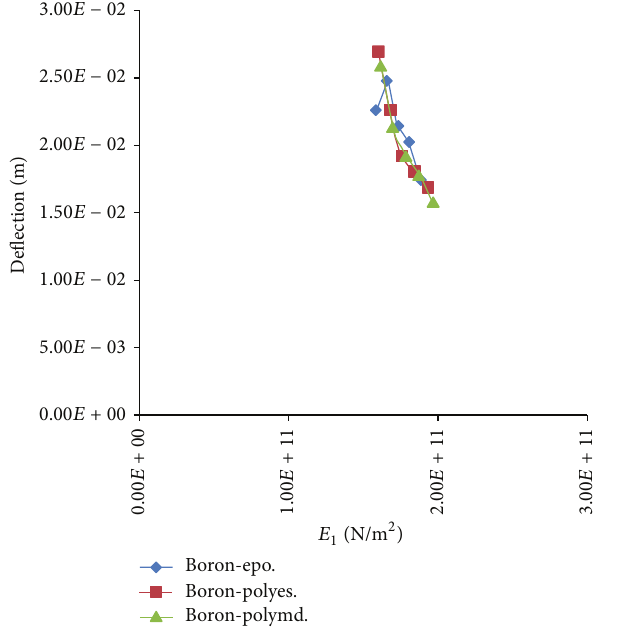
Figure 19: Effect of longitudinal modulus of elasticity on bending stresses of various composite leaf springs based on matrix